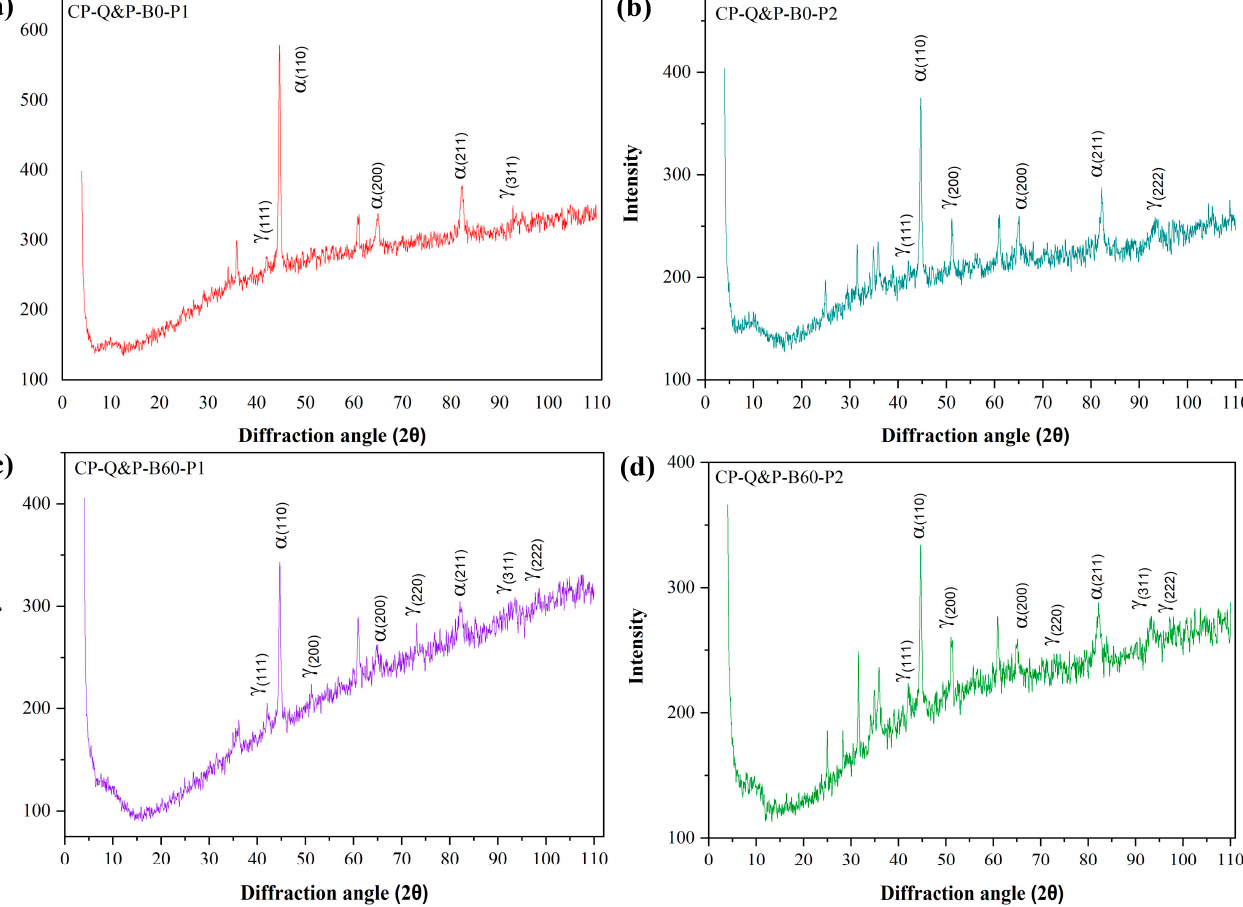
Figure 10. X-ray diffraction patterns of complex phase (CP) steels given the quenching and parti- tioning heat treatment (Q&P): ( a ) boron-free steel given partitioning treatment P1 (CP-B0-Q&P-P1), ( b ) boron-free steel given partitioning treatment P2 (CP-B0-Q&P-P2), ( c ) boron-containing steel given partitioning treatment P1 (CP-B60- Q&P-P1), and ( d ) boron-containing steel given partitioning treatment P2 (CP-B60-Q&P-P2).